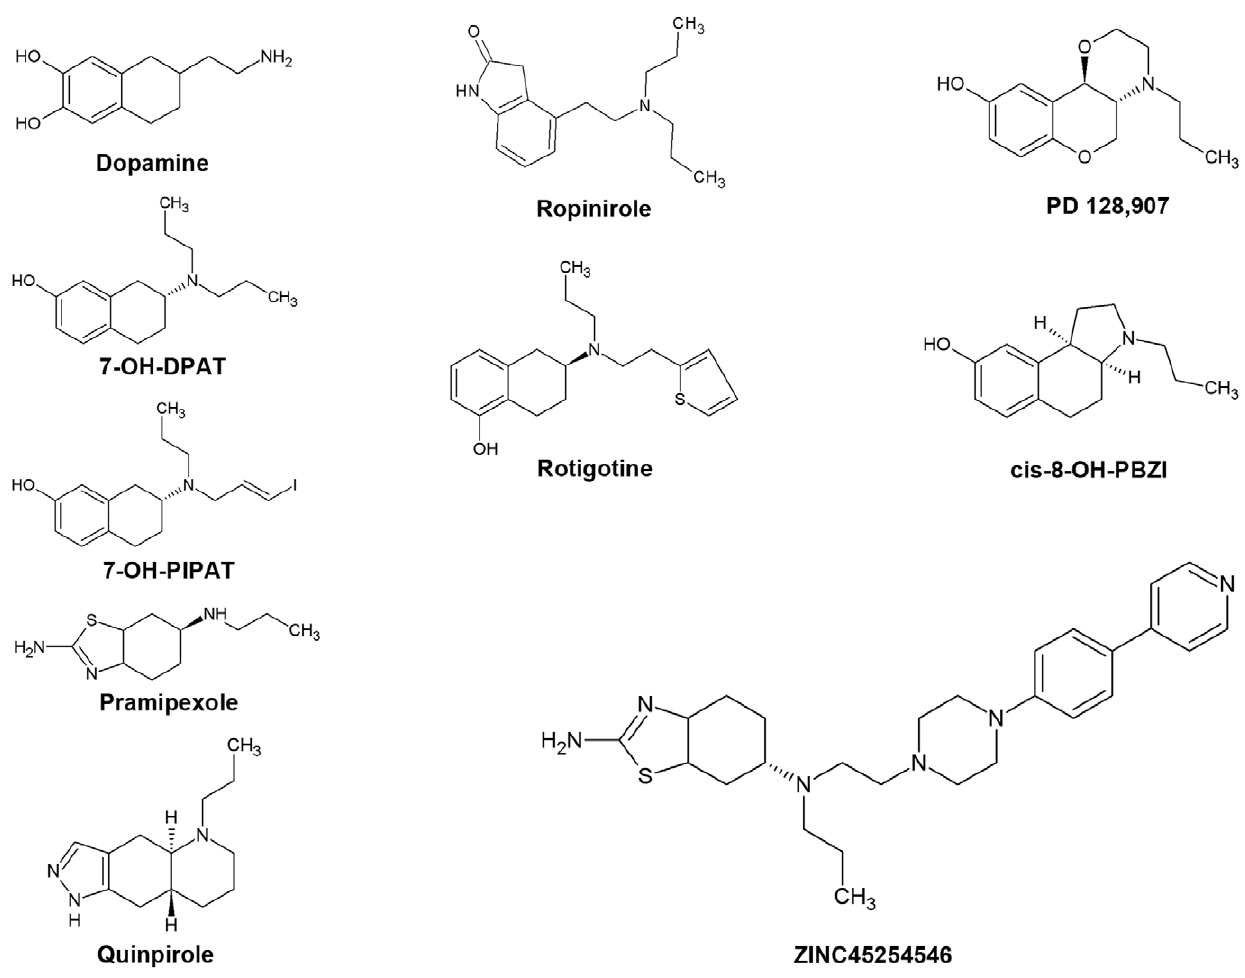
Figure 1. D 2 -like agonists.